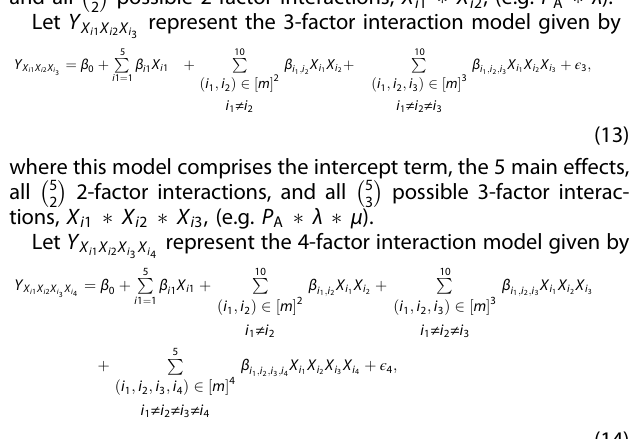
Step 2 identi fi es the best model for each subset size ( j ) based on